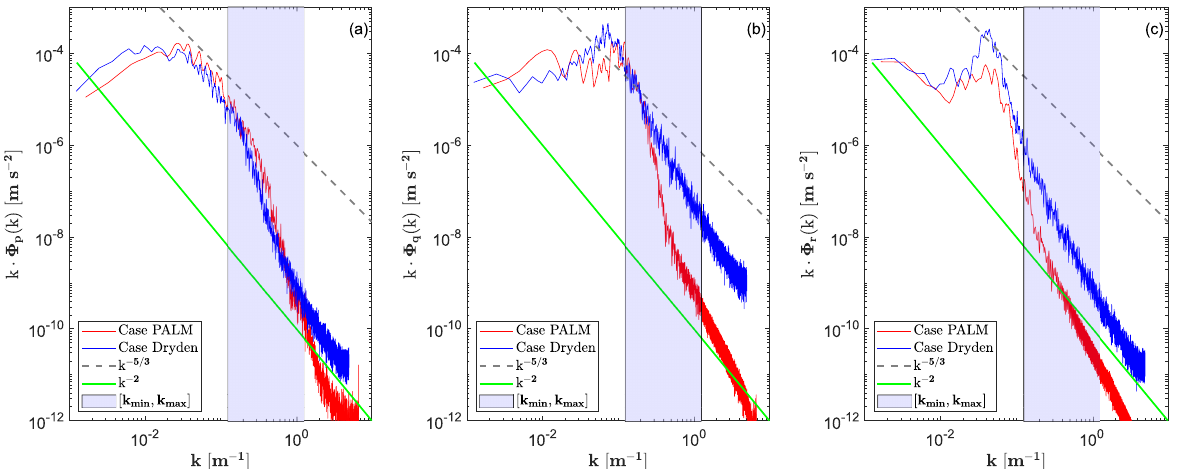
Figure 17. Spectra of airplane angular rate responses: ( a ) roll rate p , ( b ) pitch rate q and ( c ) yaw rate r , derived from flight simulation output data of scenario Piz Corvatsch at an average altitude of 7500 ft (2280 m). The grey dashed line represents the reference − 3/5-slope according to Kolmogorov’s law [71]. The − 2-slope is plotted in green. The box in light blue shading indicates the time frame of interest for the flight simulation experiment, which is determined by the lower limit wave number k min of 2 π /50 m − 1 and the high limit wave number k max of 2 π /5 m − 1 .